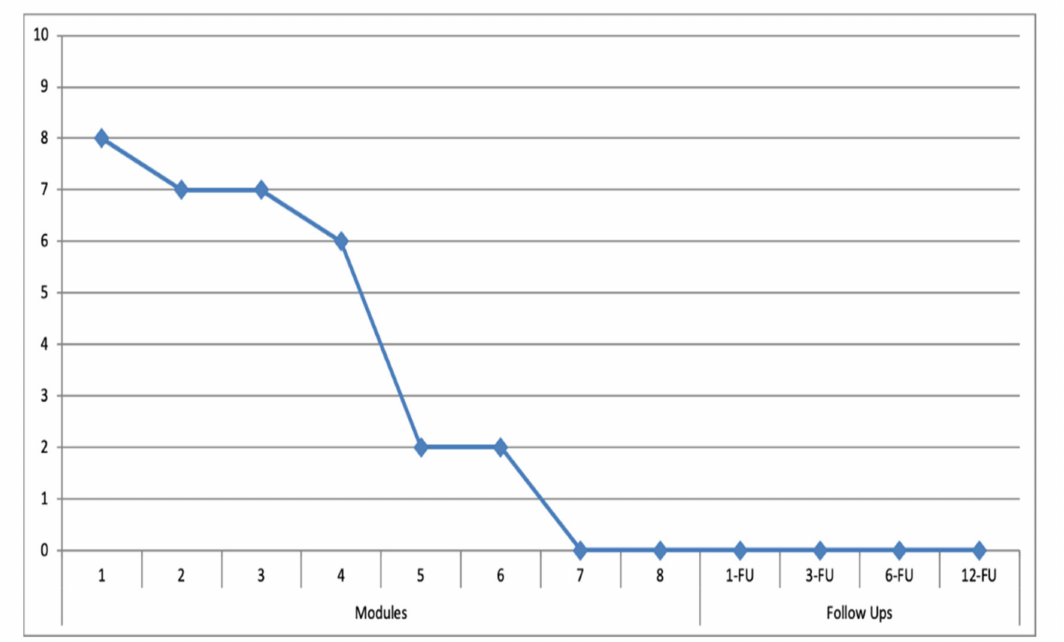
Figure 4. Overwhelming urge to play slot machines (0–10) and distrust regarding his own capacity to resist it for patient 2. (Modules = 1 to 8 session treatment; 1-FU, 3-FU, 6-FU, 12-FU: 1-, 3-, 6-, 12-month